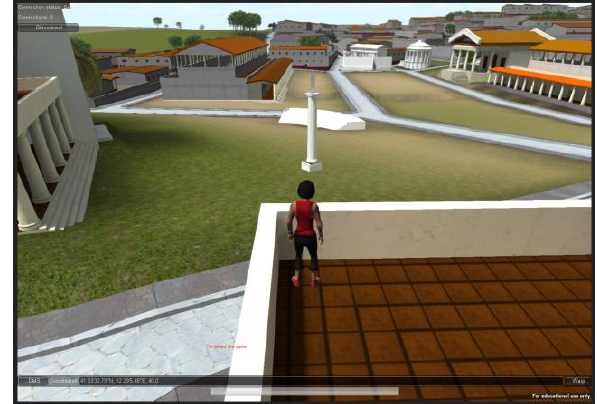
Figure 6. View of the performance area